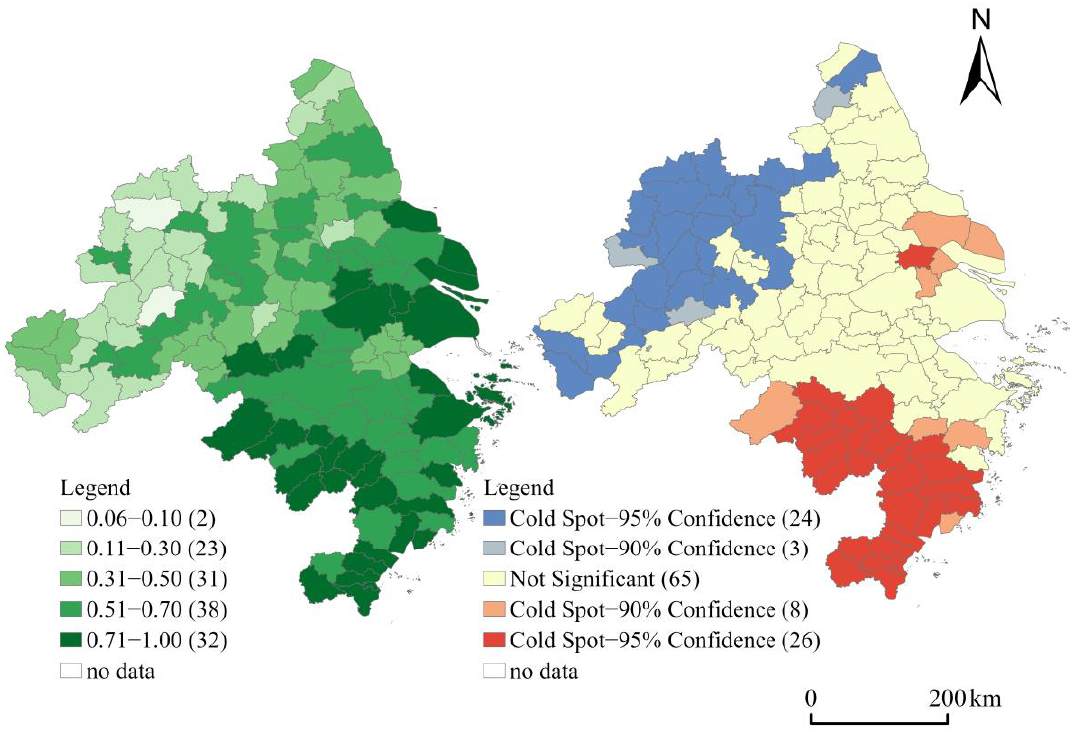
Figure 4. Analysis of land urbanization pattern and hot spots in Yangtze River Delta urban agglom- eration in 2020. ation in